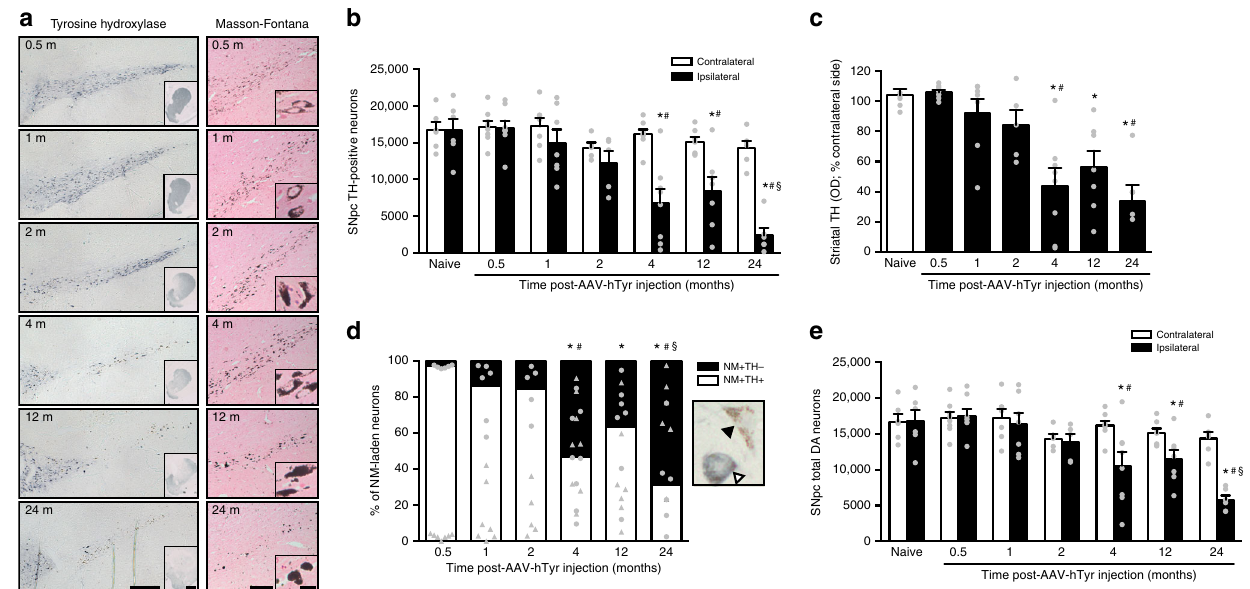
Fig. 3 Progressive nigrostriatal degeneration in AAV-hTyr-injected rats. a Left, ipsilateral SNpc and striatum (inset) sections immunostained for TH (blue). Right, ipsilateral SNpc sections stained with Masson-Fontana (NM in dark brown; inset, higher magni fi cation of melanized neurons). Scale bars, 300 μ m (left), 2 mm (left inset), 150 μ m (right), and 12.5 μ m (right inset). b Stereological cell counts of SNpc TH-positive neurons in AAV-hTyr-injected rats. * p < 0.05, compared to respective contralateral (non-injected) side; # p ≤ 0.05, compared to ipsilateral naive, 0.5, 1, and 2 m; § p < 0.05, compared to ipsilateral 4 and 12 m (two-way ANOVA; Student – Newman – Keuls post-hoc test). c Optical densitometry of striatal TH-positive fi bers in AAV-hTyr- injected rats. * p < 0.05, compared to 0.5 m; # p < 0.05, compared to naive (ANOVA on ranks; Dunn ’ s post-hoc test). d Stereological cell counts of SNpc NM + /TH + (white arrowhead) and NM + /TH − (black arrowhead) neurons vs total NM + neurons in AAV-hTyr-injected rats. * p < 0.05, compared to 0.5 m; # p < 0.05, compared to 1 and 2 m; § p < 0.05, compared to 12 m (one-way ANOVA; Student – Newman – Keuls post-hoc test). e Stereological cell counts of total SNpc DA neurons (including TH-immunopositive and TH-immunonegative melanized neurons) in AAV-hTyr-injected rats. * p < 0.05, compared to respective contralateral side; # p < 0.05, compared to ipsilateral naive, 0.5 and 1 m; § p < 0.05, compared to ipsilateral 2, 4, and 12 m (two-way ANOVA; Student – Newman – Keuls post-hoc test). In all panels, values are mean ± SEM. In a – e , n = 6 (Naïve), n = 8 (0.5 m), n = 7 (1 m), n = 5 (2 m), n = 8 (4 m), n = 7 (12 m), and n = 6 (24 m). Photomicrographs correspond to 5- μ m-thick